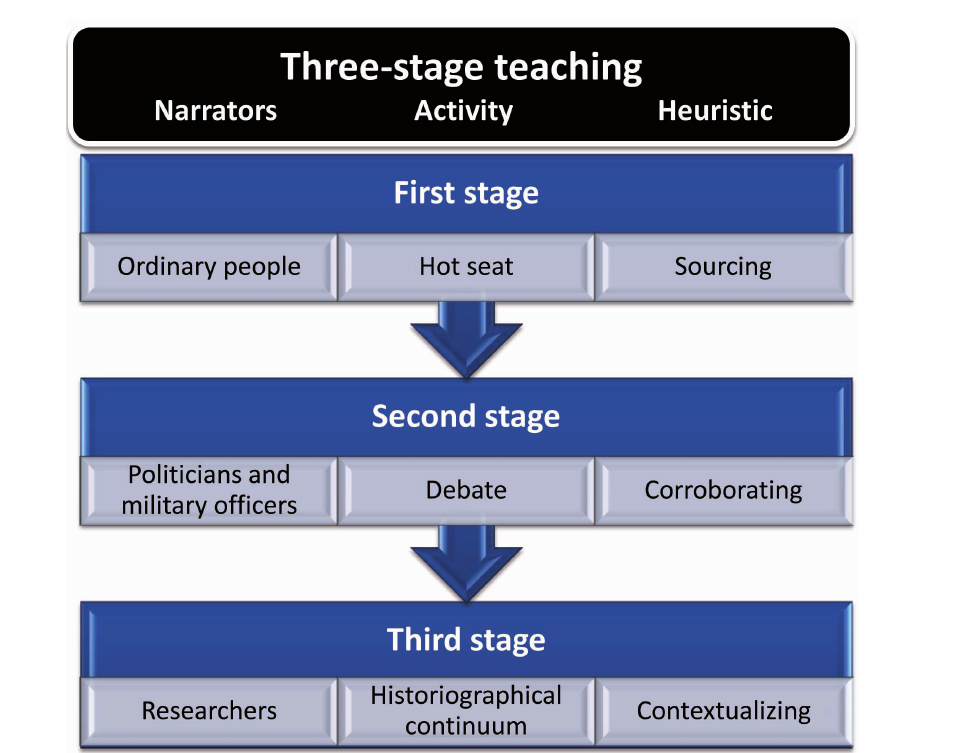
Figure 2: The stages of the teaching and their characteristics